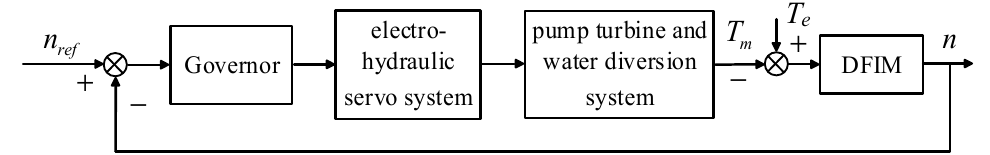
Figure 1. Structure diagram of the DFVSPS.